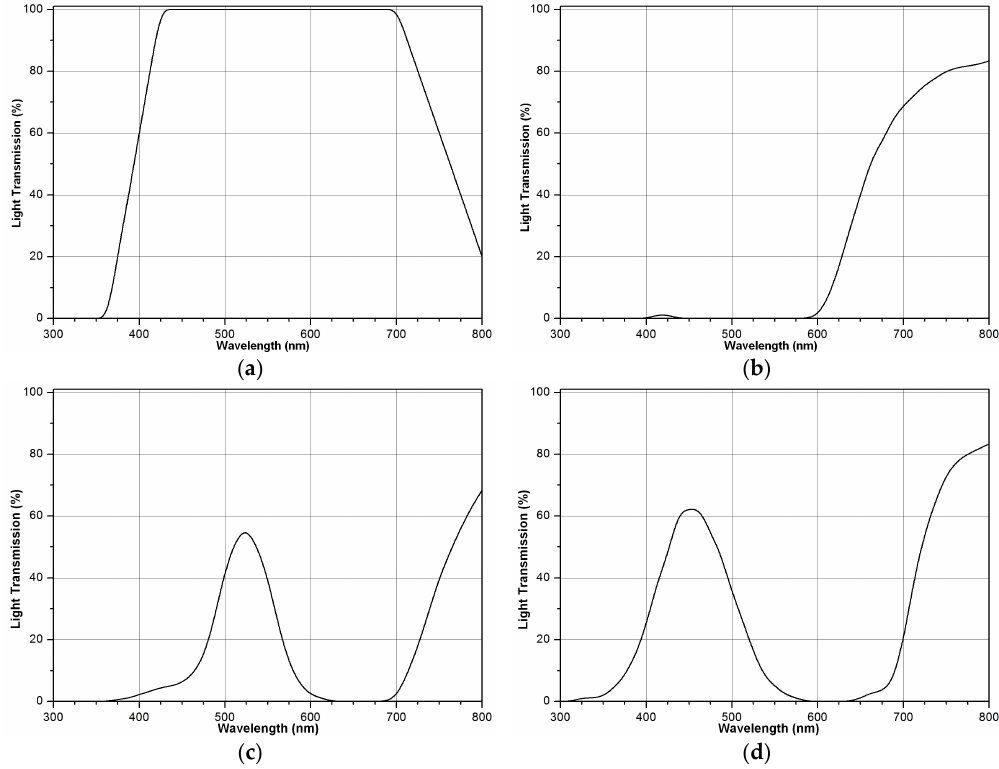
Figure 2. Spectral energy distribution (SED) curves of the primary filters: ( a ) visible light; ( b ) red; ( c ) green; ( d ) blue. The original names of the filters adopted by the manufacturer are, respectively: Heat Shield, Medium Red, Dark Green and Medium